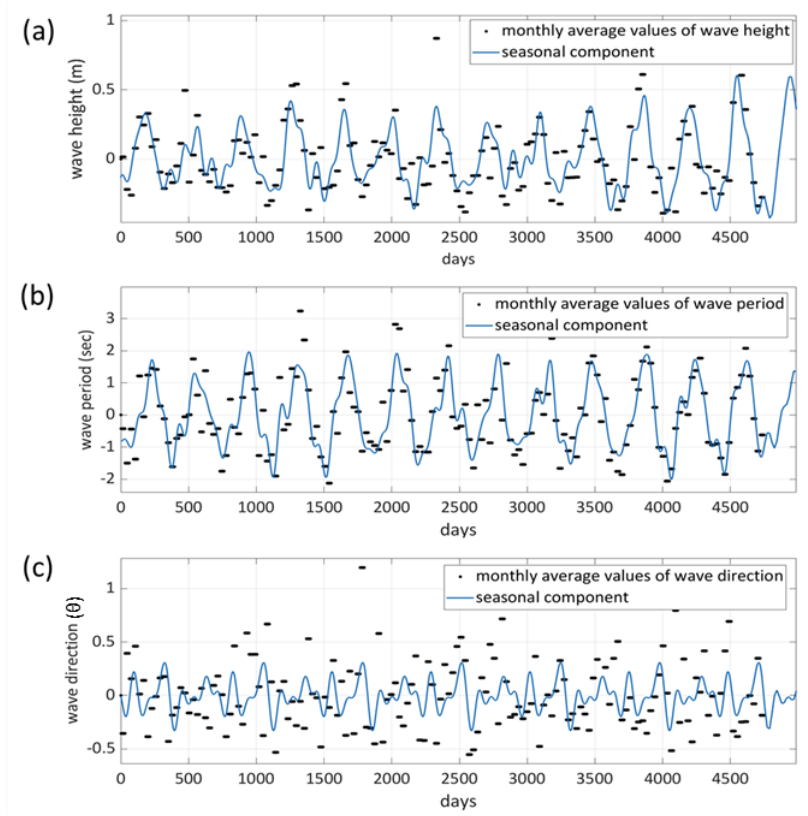
Figure 6. The upper panel ( a ) shows the seasonal component of significant wave height ( H s ), simi- larly, the middle panel ( b ) depicts the seasonal component of peak wave period, and finally, the lower panel, ( c ), shows the seasonal component of wave direction θ ( α